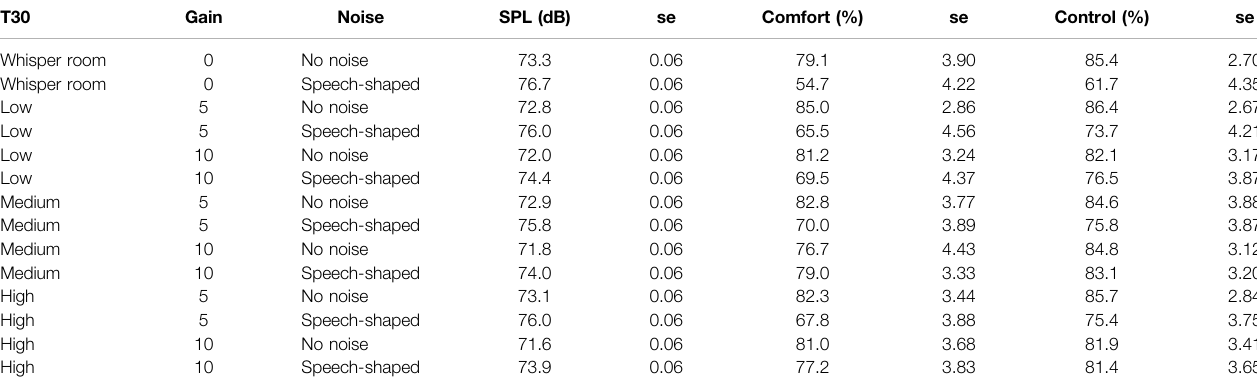
TABLE 2 | Mean values and standard error (se) for the variable SPL in dB(A), perceived vocal comfort, and control in %, for the 14 conditions. T30 Gain Noise SPL